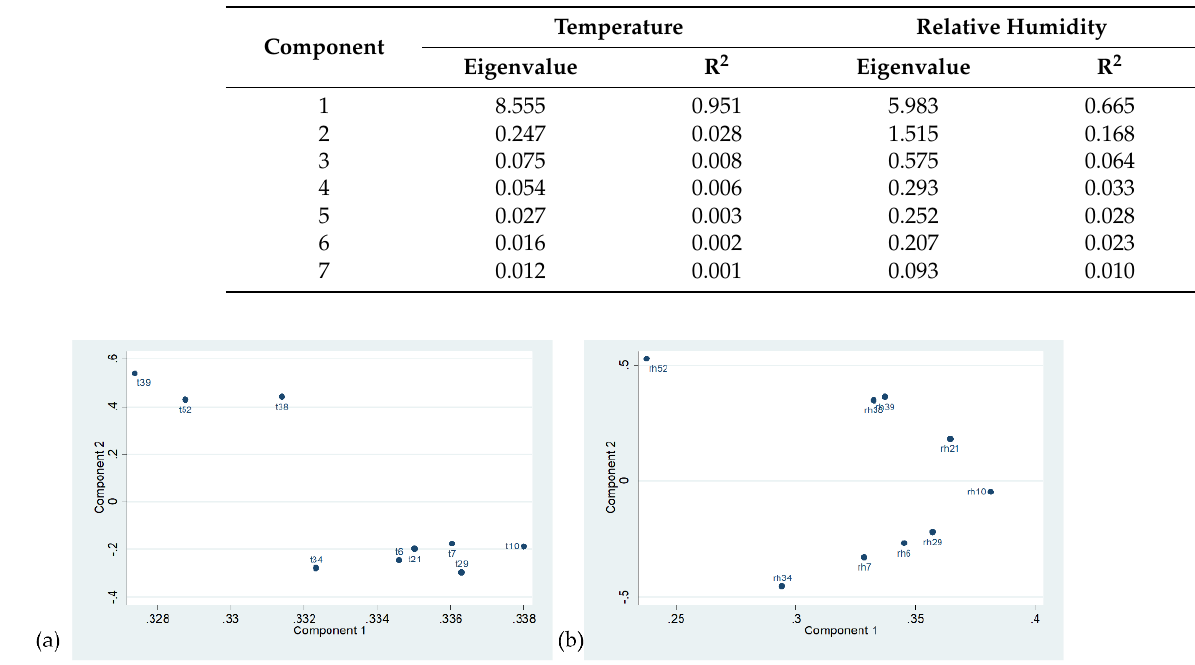
Table 4. Summary of PCA outcomes obtained from hourly observations of temperature and RH (R2 is the proportion of variability explained by each component).